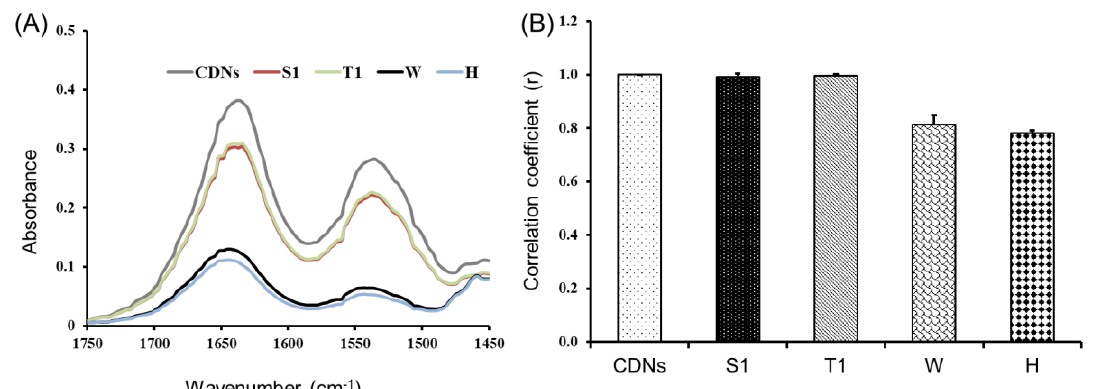
Figure 2. Characterization of the overall secondary structure of proteins in CDNs. ( A ) ATR-FTIR spectra of freshly prepared CDNs, lyophilized CDNs with either sucrose (S1) or trehalose (T1) as lyoprotectants, non-lyoprotected CDNs (W), and heat-denatured CDNs (H) in the 1750–1450 cm − 1 spectral region. ( B ) Correlation coefficient (r) values comparing ATR-FTIR spectra of freshly prepared CDNs and the different CDN lyophilization groups. Data represent mean ± SD determined from three independent experiments ( n = 3).